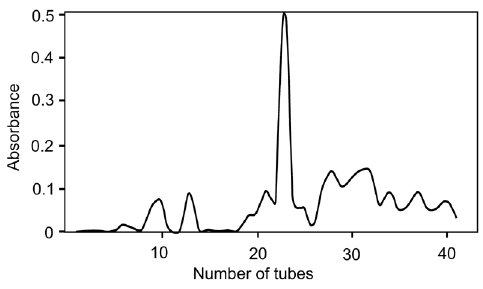
Fig. 1. DEAE-cellulose column chromatogram of POPs.